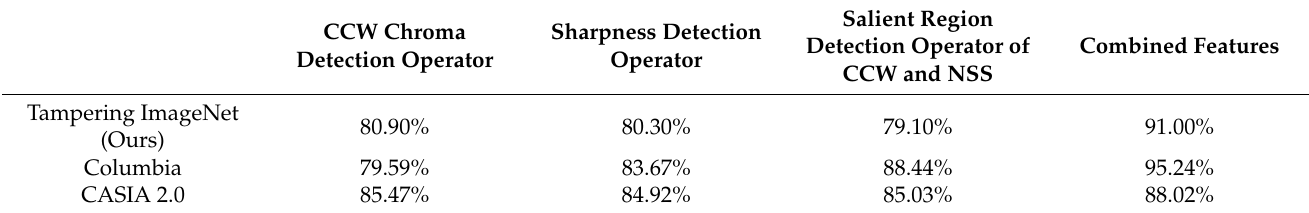
Table 2. The accuracy of the single feature and combined features.